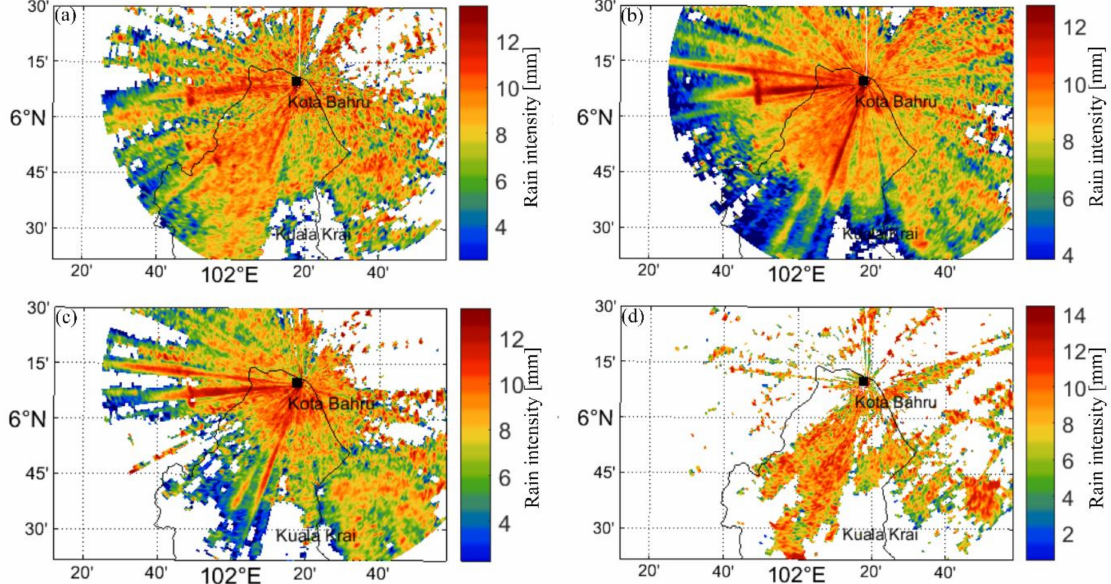
Figure 14. CAPPI map on daily basis generated from the ANN model from the KB weather radar for similar date as Figure 13. ( a ) 16 December 2014, ( b ) 17 December 2014, ( c ) 18 December 2014, and ( d ) 19 December